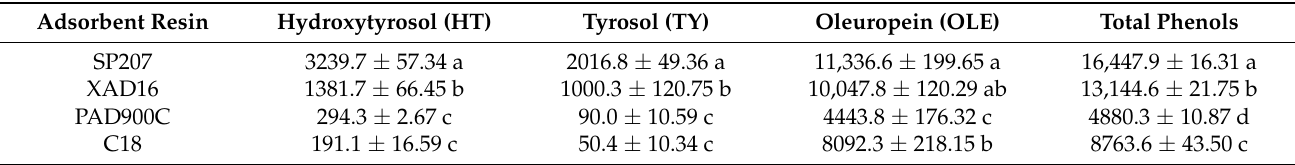
Table 2. Phenols detected in OMW extracts obtained with the different tested resins.